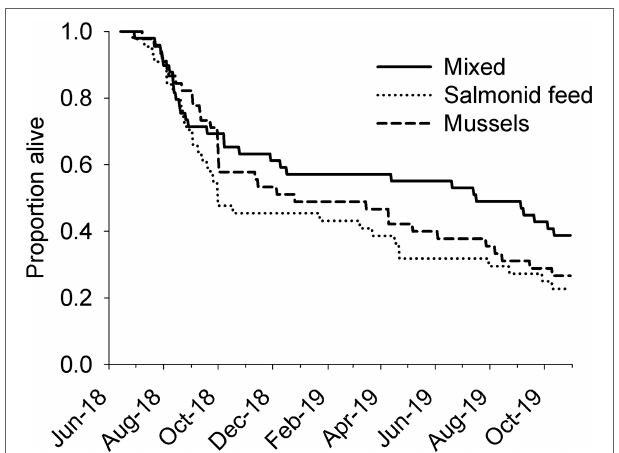
FIGURE 2 | Survival of rock crabs Cancer irroratus fed different aquaculture- related diets in a laboratory experiment. Survival was not significantly influenced by diet (Kaplan-Maier log-rank survival analysis, n = 45-50 for each treatment).